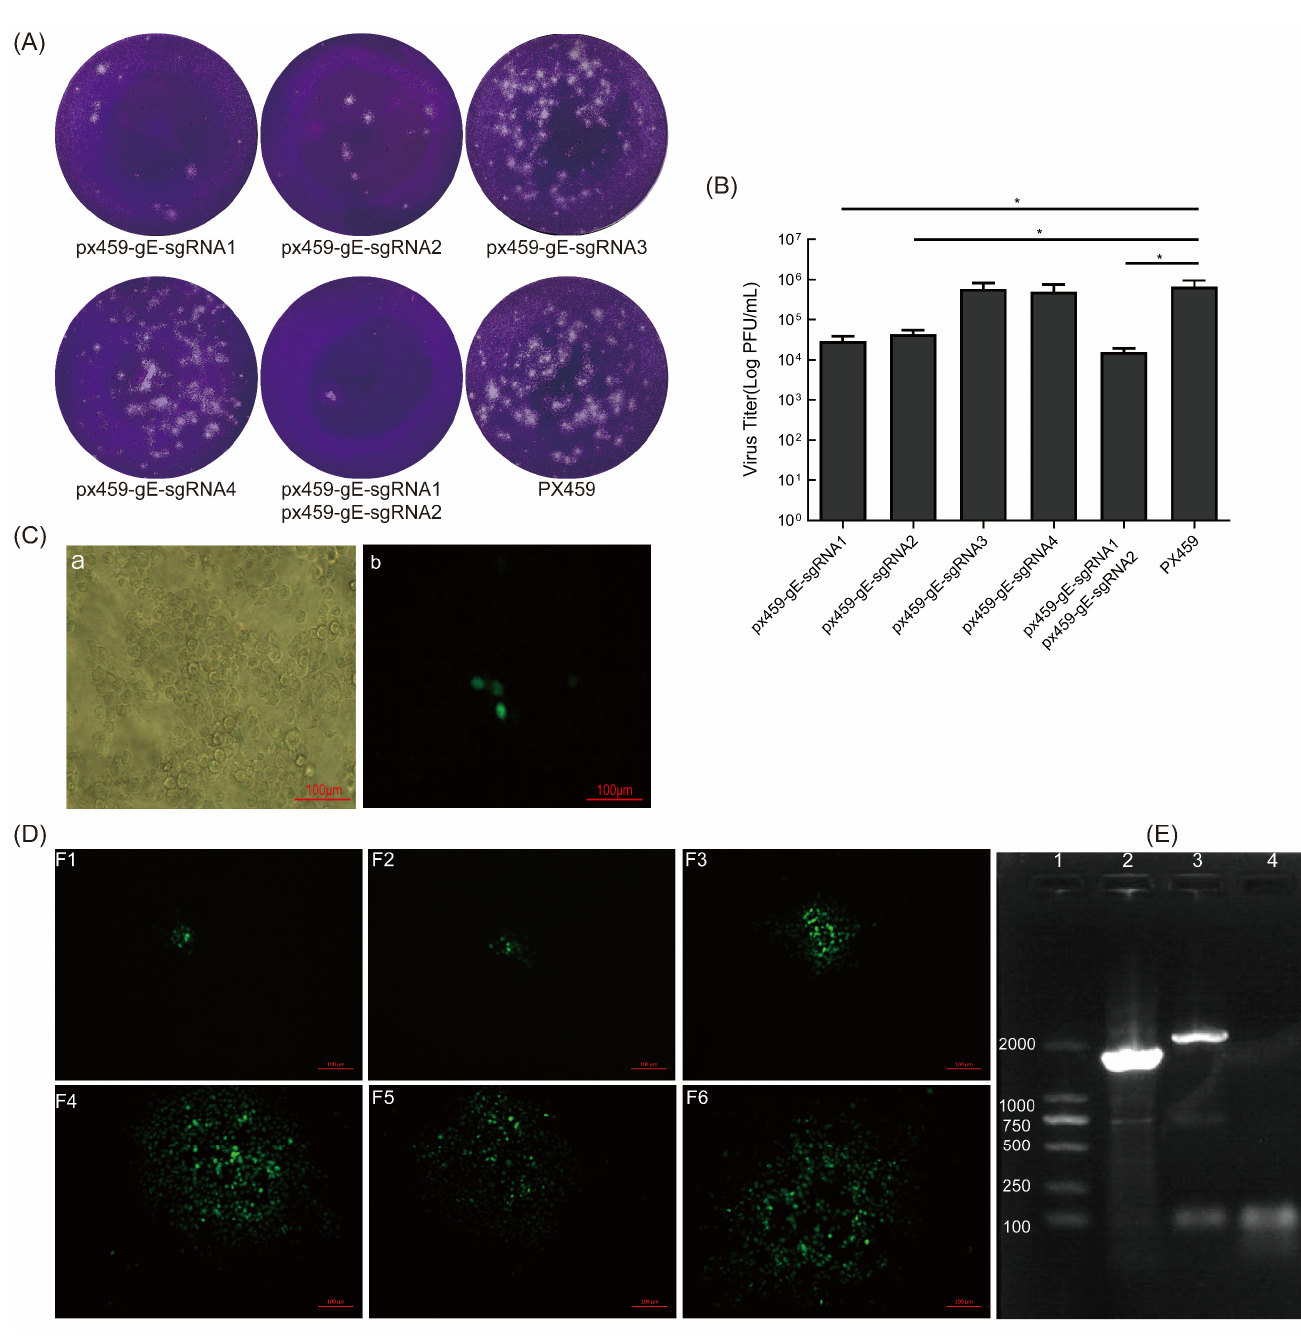
Figure 2. sgRNA of gE inhibits BoHV-1 replication and screening of BoHV-1 gE/EGFP + . ( A ) sgRNA inhibits the formation of BoHV-1 plaques. A total of 2 μ g of px459-gE-sgRNA1, 2, 3, 4, and px459 were co-transfected into VERO E6 cells. After 12 h, the cells were infected with BoHV-1 (MOI = 1). The virus was collected at 72 hpi and a plaque assay was performed. ( B ) The virus titer of BoHV-1 when it was proceeded with sgRNA of gE on MDBK cells. ( C ) The fluorescent cells indicated that BoHV-1 gE/EGFP + was produced. ( a ) bright field; ( b ) F0 of rescued recombinant virus. ( D ) The fluorescent spot when cloning and purifying the EGFP-positive viruses. ( E ) PCR identification of BoHV-1 gE/EGFP + . The viral genome was extracted from the supernatant after the purification of sixth-generation clones. PCR amplification was performed using BoHV-gE-F/R primers. The negative control was double distilled water. Lane 1: DNA marker 2000, lane 2: BoHV-1gE/EGFP + , lane 3: wtBoHV-1, lane 4: negative control. The data are shown as mean ± SD; * p < 0.05.